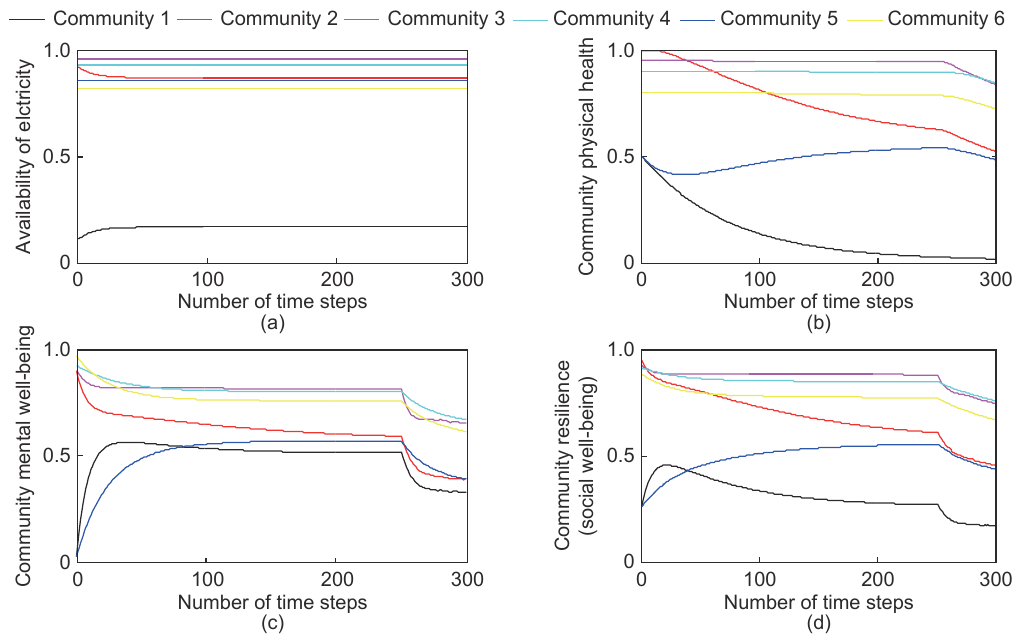
Fig. 11 Average dynamic change of availability of electricity, physical health, mental well-being, and community resilience for the six communities. Although the resilience of Community 1 is similar to that of Community 5 at the beginning of the disasters, these two communities do not exhibit the same trends. Because of the availability of emergency services and electricity during the disaster, the resilience of Community 5 increases over